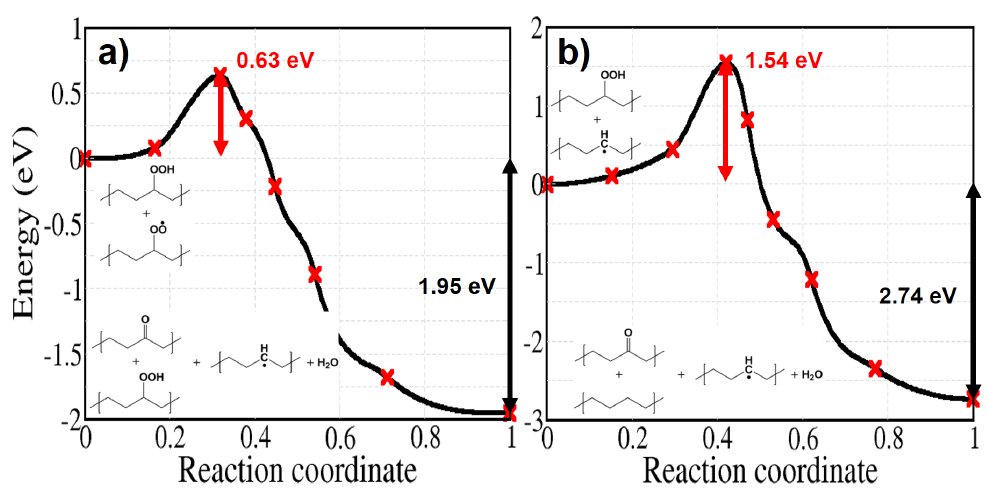
Figure 15. Energy profiles for hydroperoxide decomposition reactions induced by ( a ) a peroxy radical ( b ) an alkyl radical, sitting on a nearby polymer